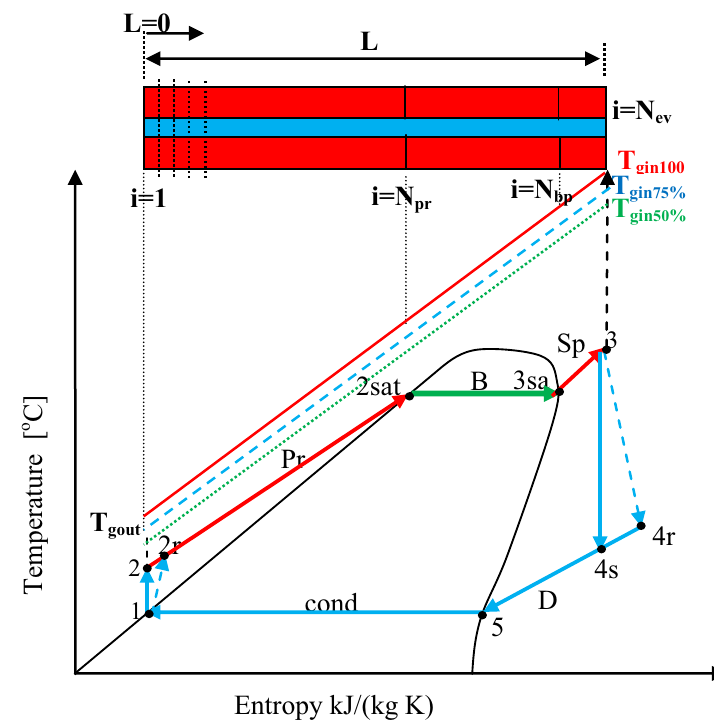
Fig. 1. T – S diagram of the ORC system.